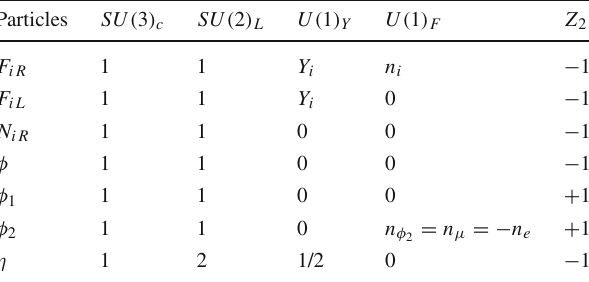
Table 1 The charge assignments of new particles under the full gauge group SU ( 3 ) c × SU ( 2 ) L × U ( 1 ) Y × U ( 1 ) F . Our choice of U ( 1 ) F charge of φ 2 is related to our choice of particular solution of the axial anomaly free equations. In this particular choice, φ 2 gives masses to F e and F μ and φ 1 gives mass to F τ . Where index i = e ,μ,τ and our Y of SM U ( 1 ) Y is same as Y in the usual 2